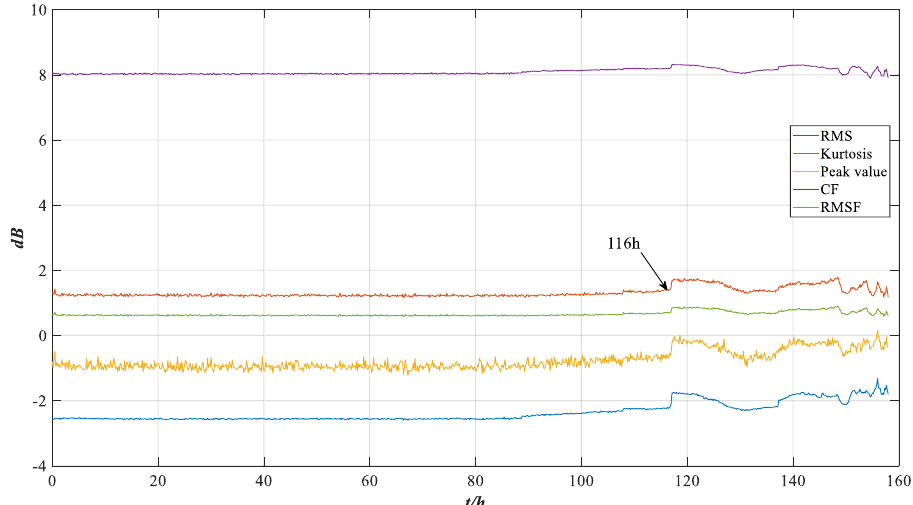
Figure 16. The trend of characteristic indicators.